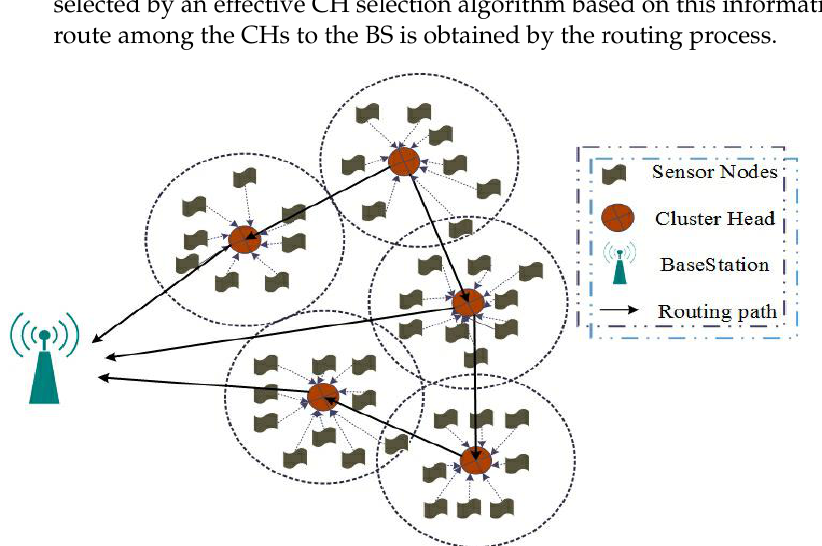
Figure 1. Structure of WSN network model.